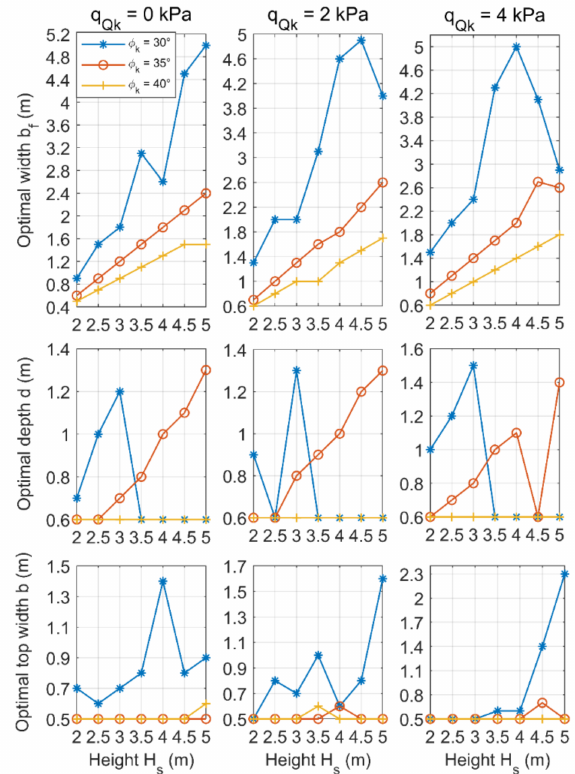
Figure 8. Optimal design for k = 2/3, β = 20 ◦ and γ = 18 kN/m 3 .